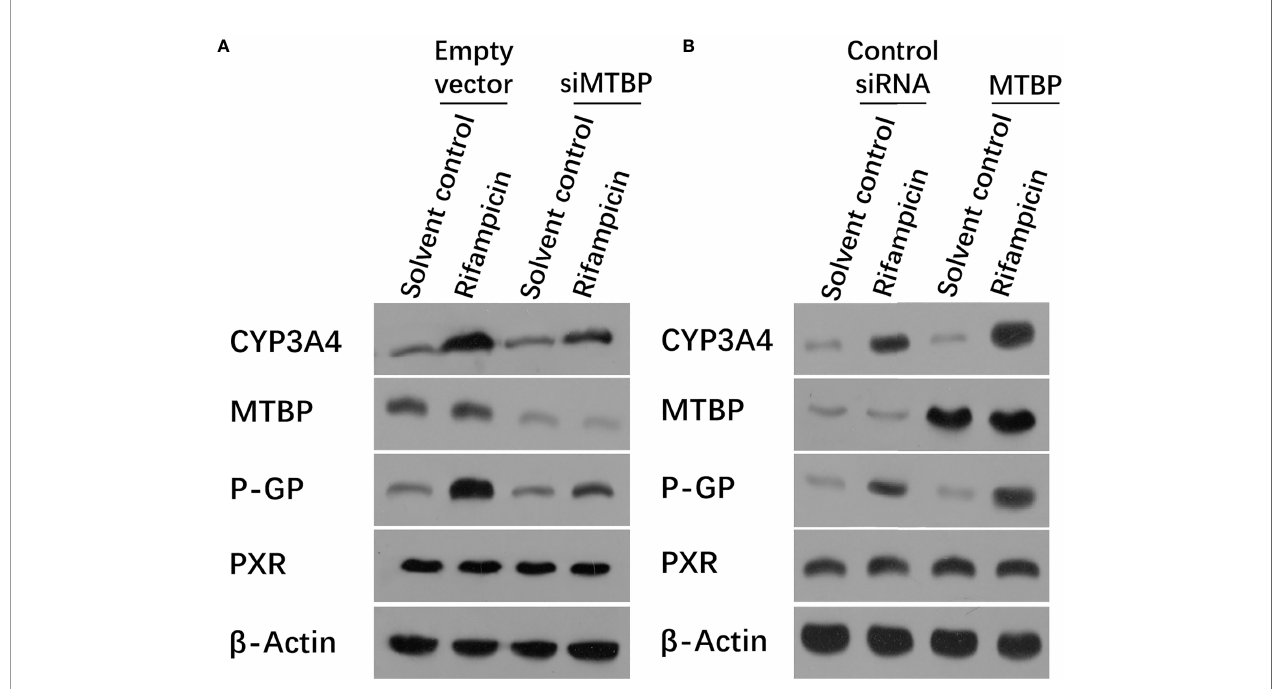
FIGURE 2 | MTBP enhanced the expression of PXR downstream genes. (A) The MHCC97-H cells were transfected with a control siRNA or the siRNA of MTBP, whereas the MHCC97-L cells were transfected with an empty vector or MTBP (B) . Cells were treated with solvent control or rifampicin (10 m mol/L concentration) and harvested for the western blot experiments. The protein levels of PXR, MTBP, CYP3A4 and P-gp (encoding by the acbc1) in these cells were examined by the antibodies. The b -Actin was chosen as the loading